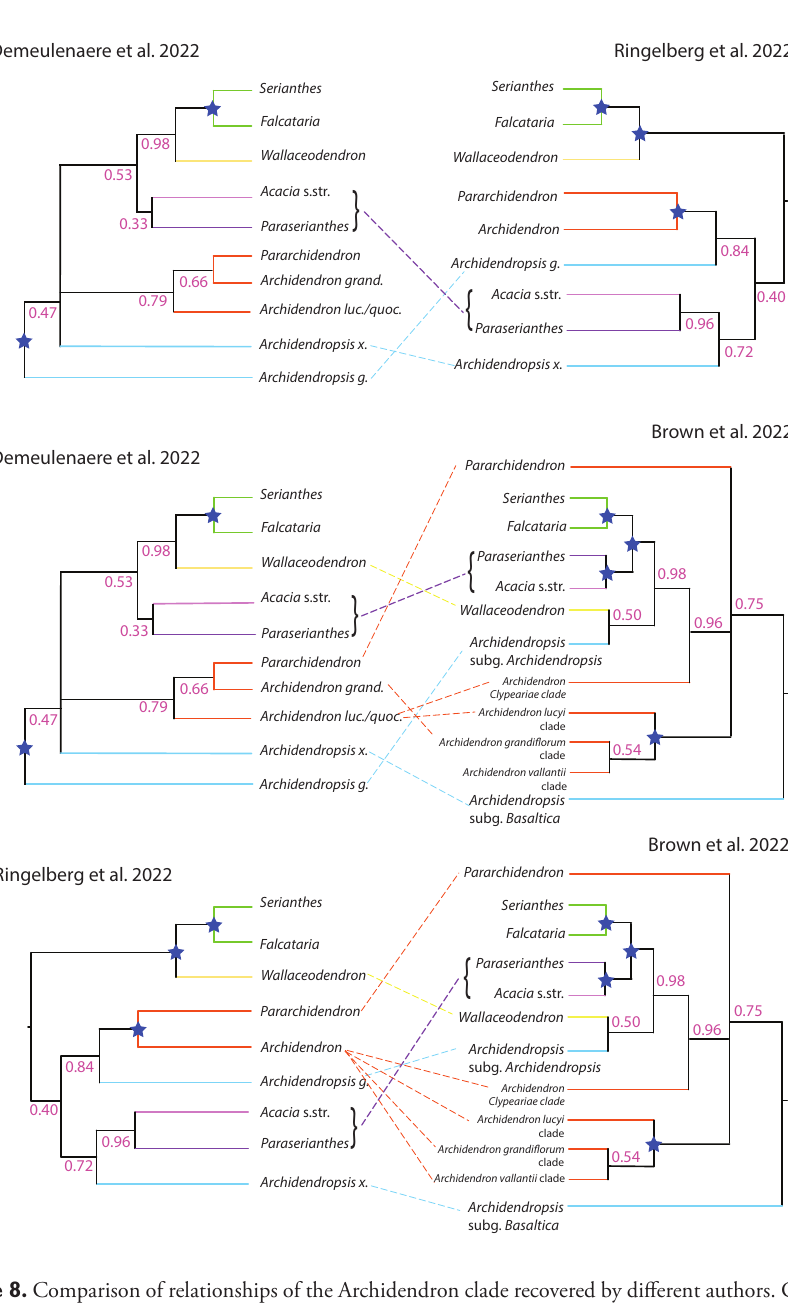
Figure 8. Comparison of relationships of the Archidendron clade recovered by different authors. Colour schemes follow those in Fig. 2. The branches that are fully supported (either by PP = 1.00 or BS = 100%) are indicated by blue stars and discordant placements of genera are indicated by dashed lines. The following abbreviations are used: Archidendron grandi. = Archidendron grandiflorum , Archidendron luc. = Archidendron lucidum , Archidendron quoc. = Archidendron quocense , Archidendropsis g. = Archidendropsis granulosa and Archidendropsis x. = Archidendropsis xanthoxylon